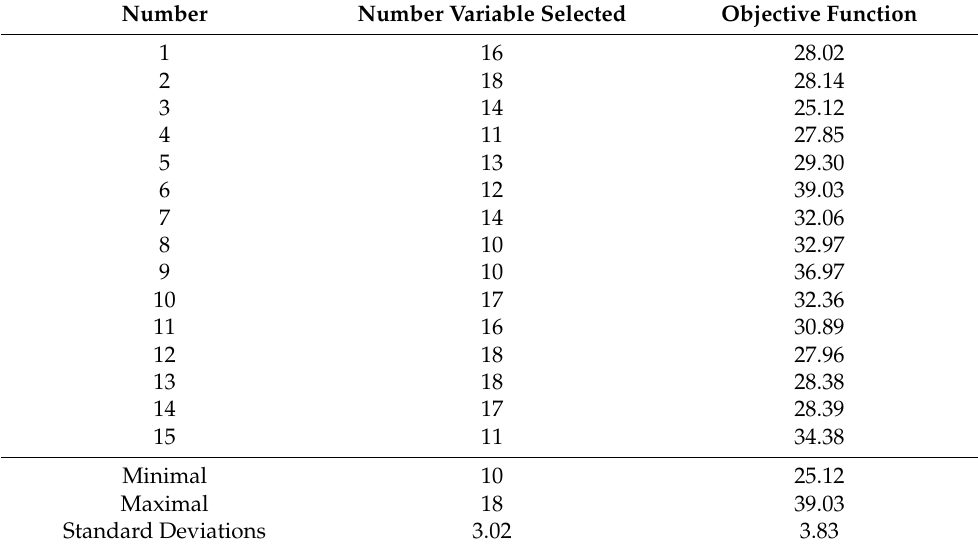
Table 7. Results of the SA-PCA algorithm with